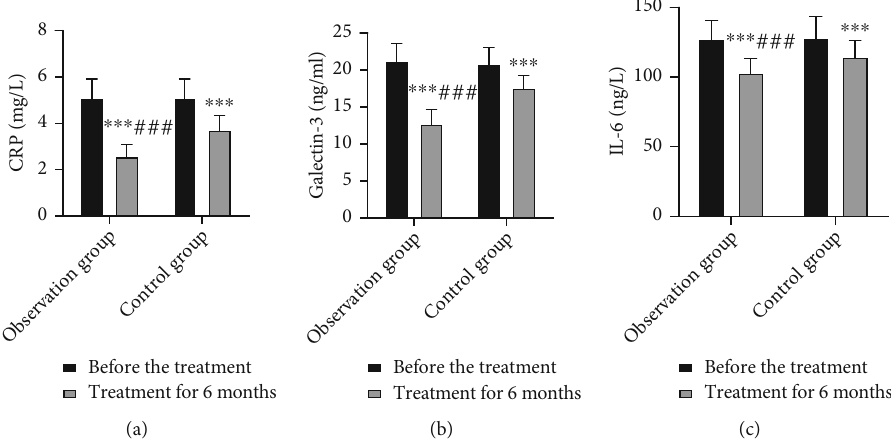
Figure 4: Comparison of serum in fl ammatory marker levels in both groups. (a) CRP levels; (b) galectin-3 levels; (c) IL-6 levels. Compared with pretreatment, ∗∗∗ P < 0 : 001 ; compared with the control group, ### P < 0 : 001 .